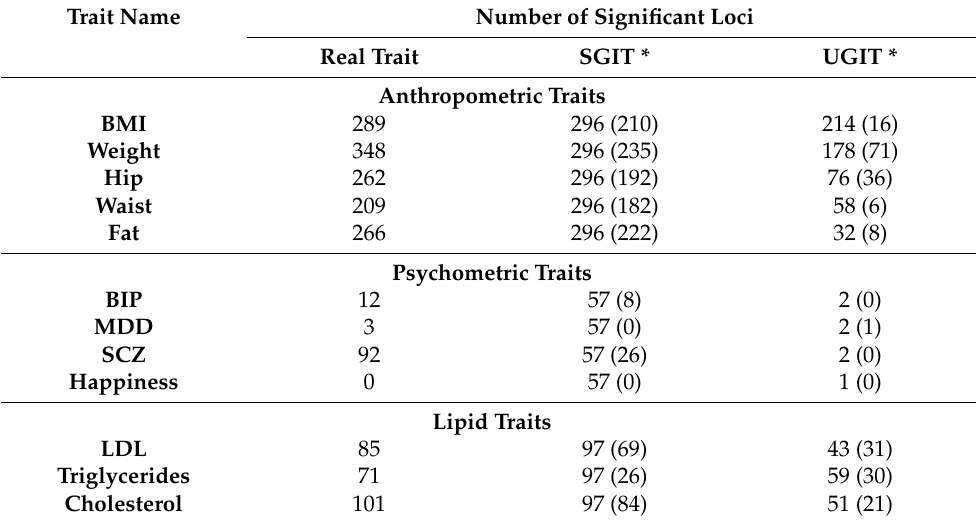
Table 1. Number of significant loci ( p -values < 5 × 10 − 8 ) identified for each trait applying SHAHER for three data